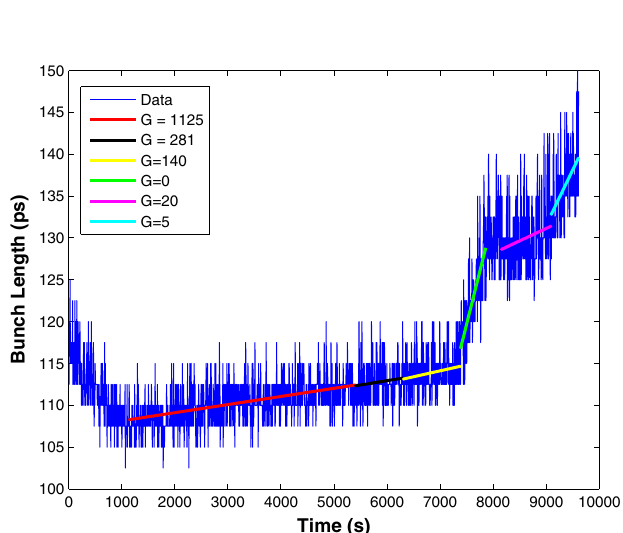
FIG. 7. Beam 1 bunch length with time.